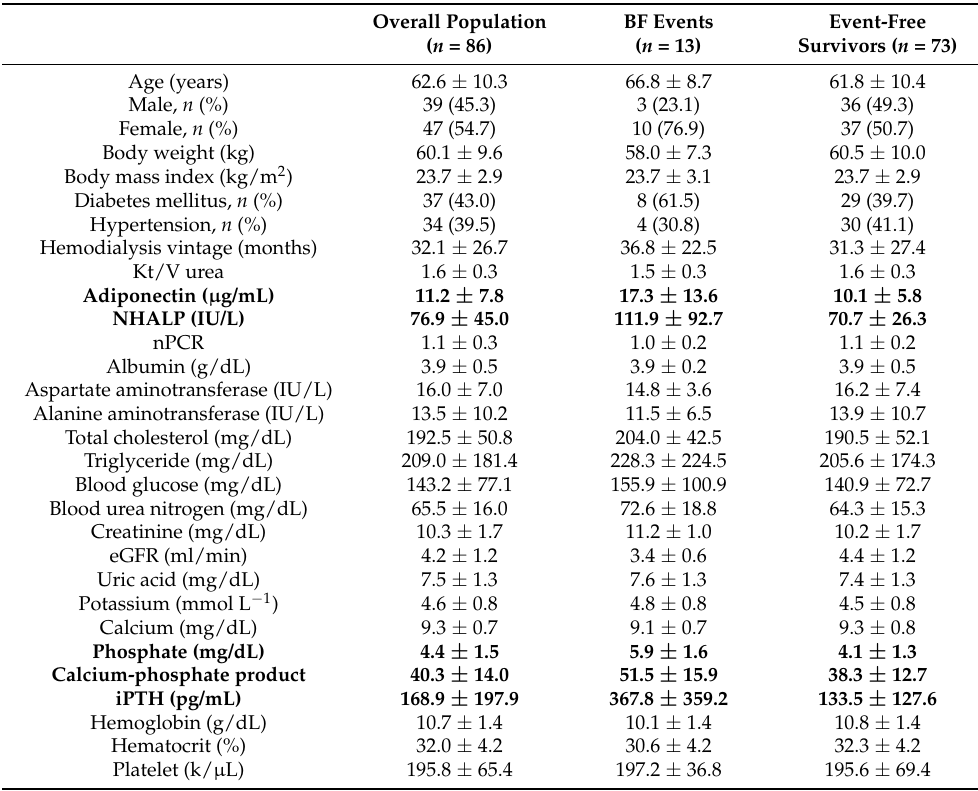
Table 1. Baseline bio-clinical data of the whole study population with comparisons between the bone fracture group and fracture-free